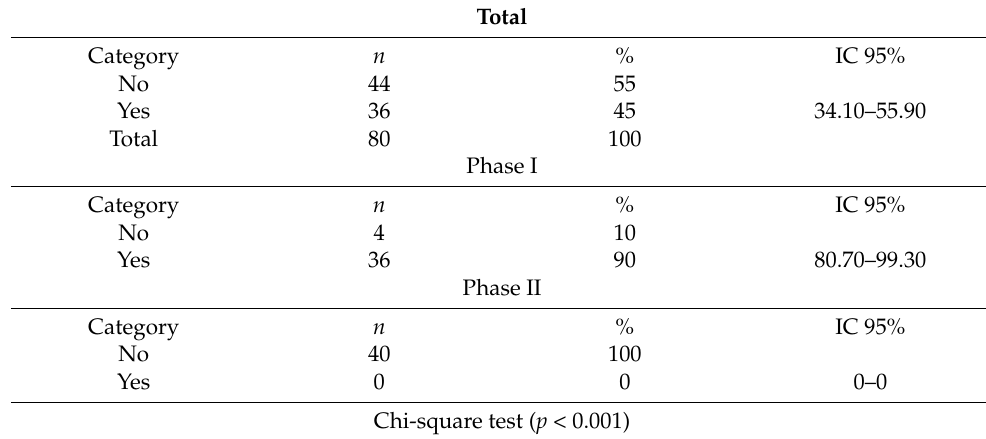
Table 4. Presence or absence of gag reflex between phase I and phase II.